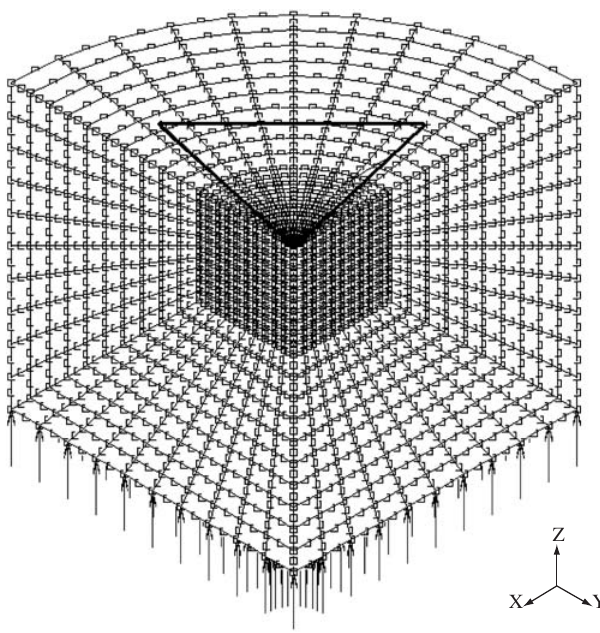
Figure 2. Numerical representation of the WC-6Co specimen and